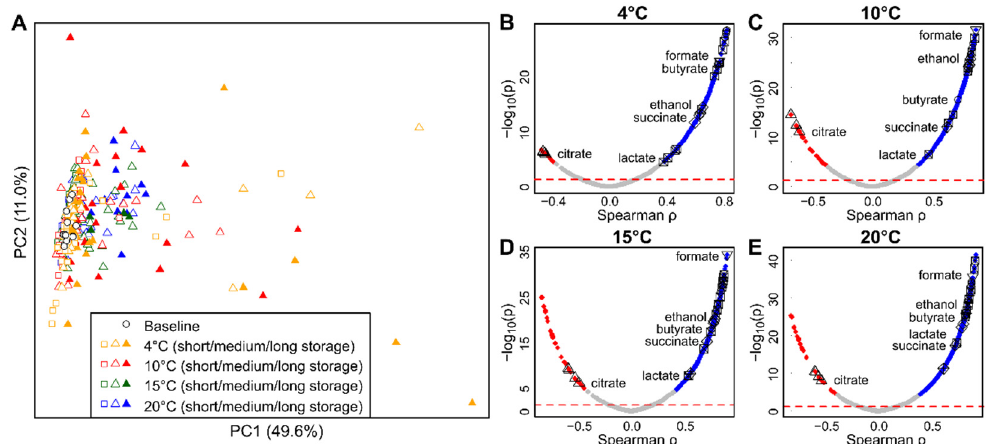
Figure 1. Untargeted NMR metabolomics analysis results. ( A ) Unsupervised analysis: principal component analysis of metabolite signals after collection (baseline) and during storage. ( B – E ) Supervised analysis: volcano plots of Spearman correlation analysis of metabolite signals and storage time at 4 ( B ), 10 ( C ), 15 ( D ), and 20 °C ( E ). Significant signals after FDR correction are highlighted in red (decreasing) or blue (increasing). The dashed line signifies nominal significance ( p = 0.05). Identified metabolite signals are marked.